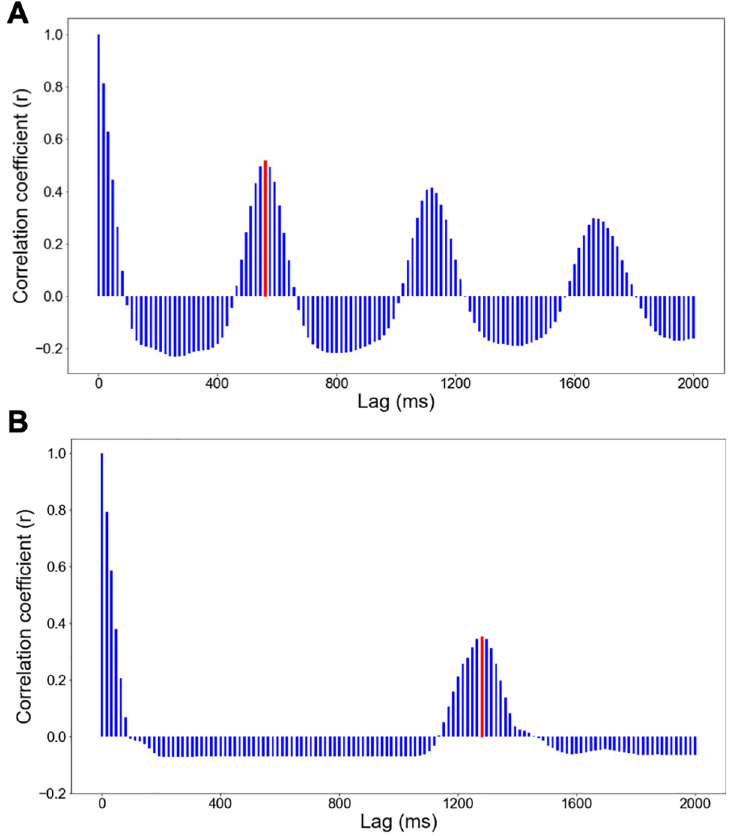
Fig 3. Illustration of the autocorrelation function. (A) Example of a participant’s autocorrelation function at high speed with a shot periodicity of 560 ms. (B) Example of a participant’s autocorrelation function at low speed with a shot periodicity of 1280 ms. On both bar graphs, the red bar indicates the first non-zero positive peak, which is used to compute the player’s shot periodicity (x-coordinate) and the player’s shot regularity (y-coordinate).